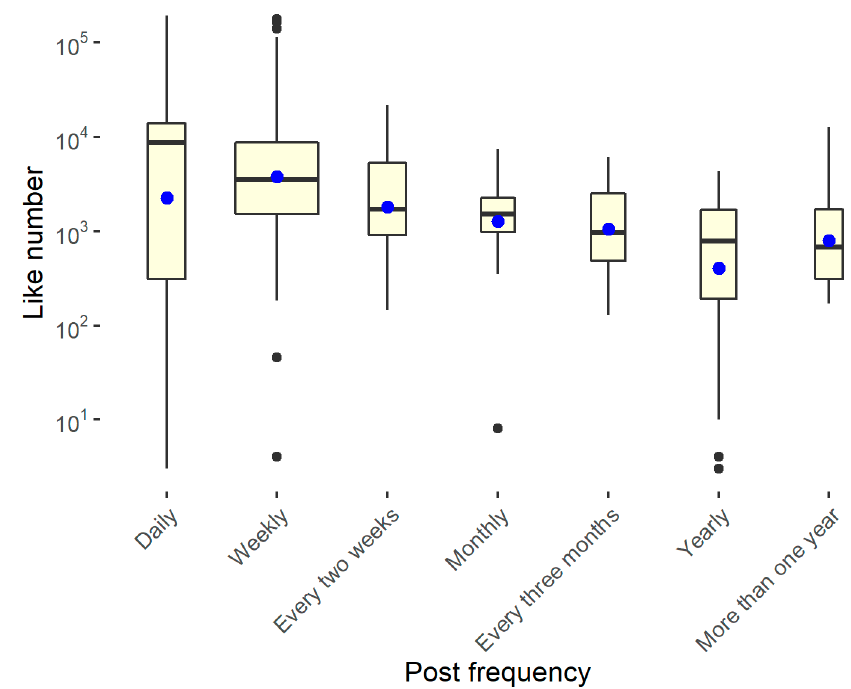
Figure 11. Comparation between like number and frequency of